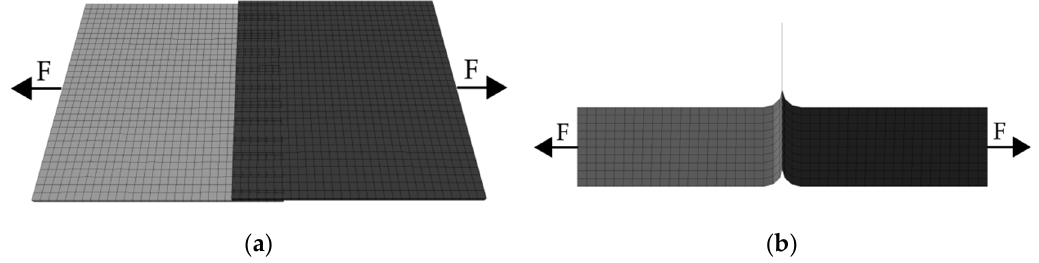
Figure 11. FEA models of welded textile membranes under shearing load: ( a ) Shear test and ( b ) peeling test.